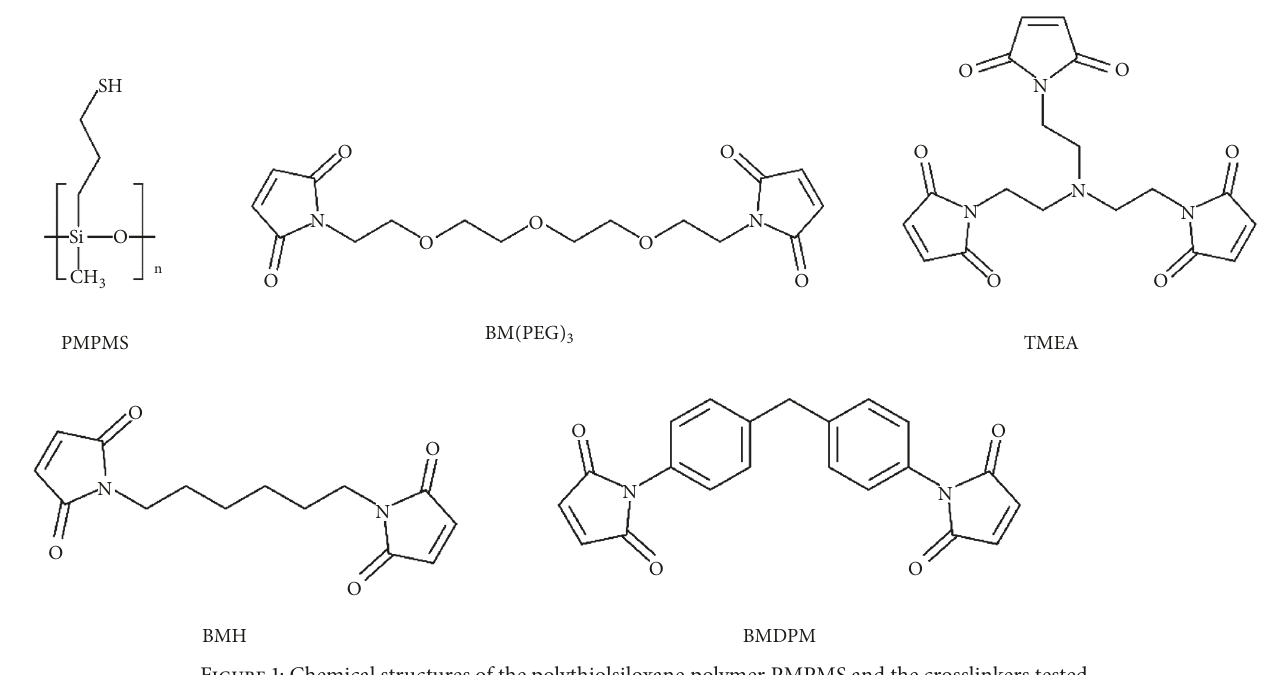
Figure 1: Chemical structures of the polythiolsiloxane polymer PMPMS and the crosslinkers tested. Table 1: Crosslinker properties. “Arm length” refers to distance between the two maleimide C=C bonds. Arm lengths for BMH and BMDPM are predictions from Scifinder, while those for BM(PEG) 3 and TMEA were provided by the